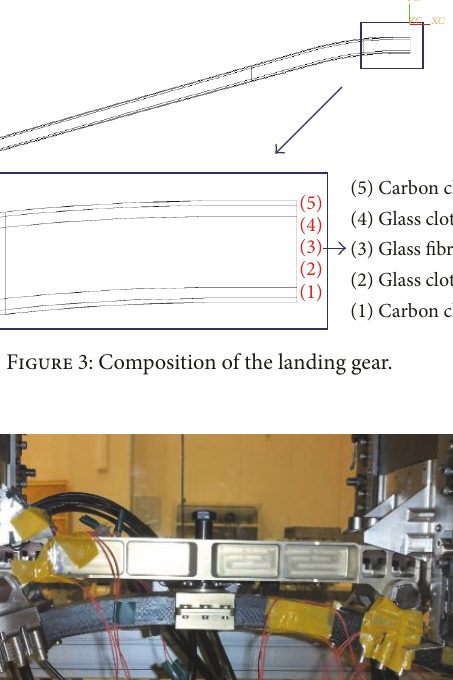
Table 1: Frequency versus mode number.